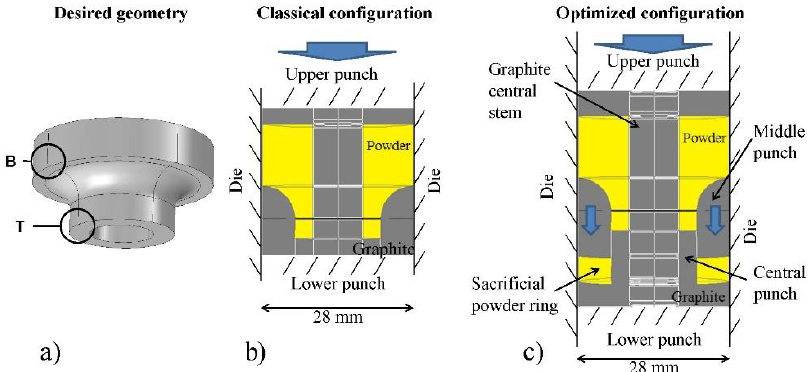
Figure 6. An illustration of the sacrificial material approach with ( a ) showing the desired geometry, ( b ) presenting the traditional configuration and ( c ) displaying the sacrificial material configuration reproduced from [69], with permission from Elsevier, 2016.